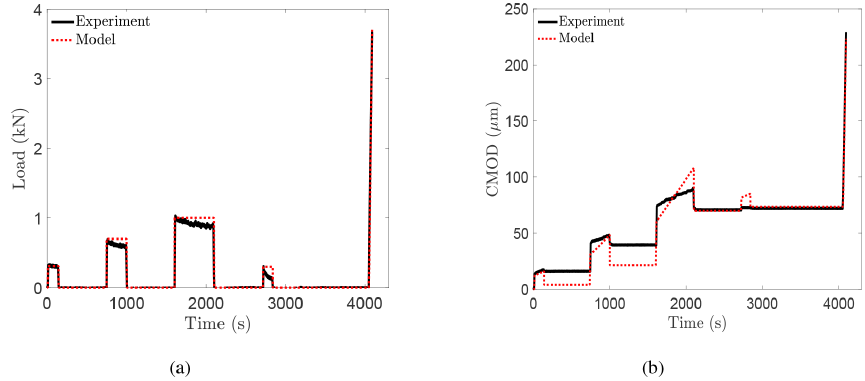
Figure 9. Experimental and model results for RP16. (a) Load at the crack mouth; see Fig. 1. (b) CMOD–time records.